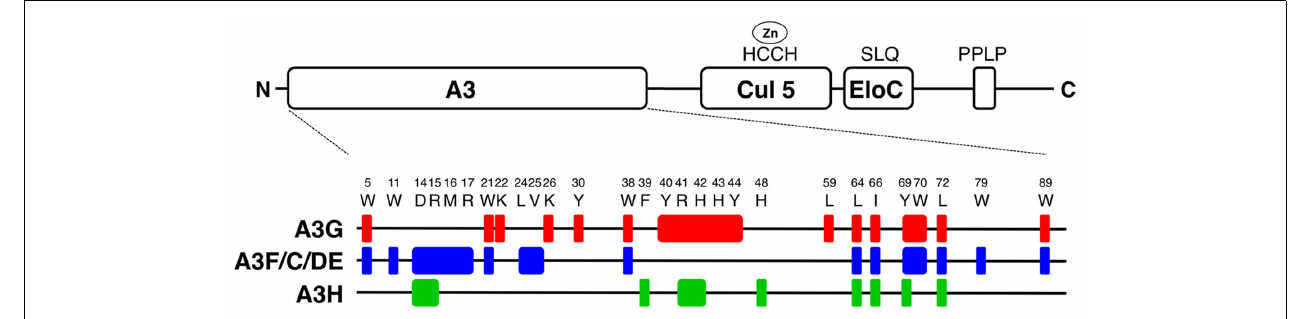
Cul5, and Elo C, andVif dimerization, respectively.The positions and the names of amino acid residues that were identified by several groups are shown.The residues that were identified as important for forming an interface with human A3 proteins are mapped inVif, i.e., A3G (red), A3F, A3C, and A3DE (blue), and A3H